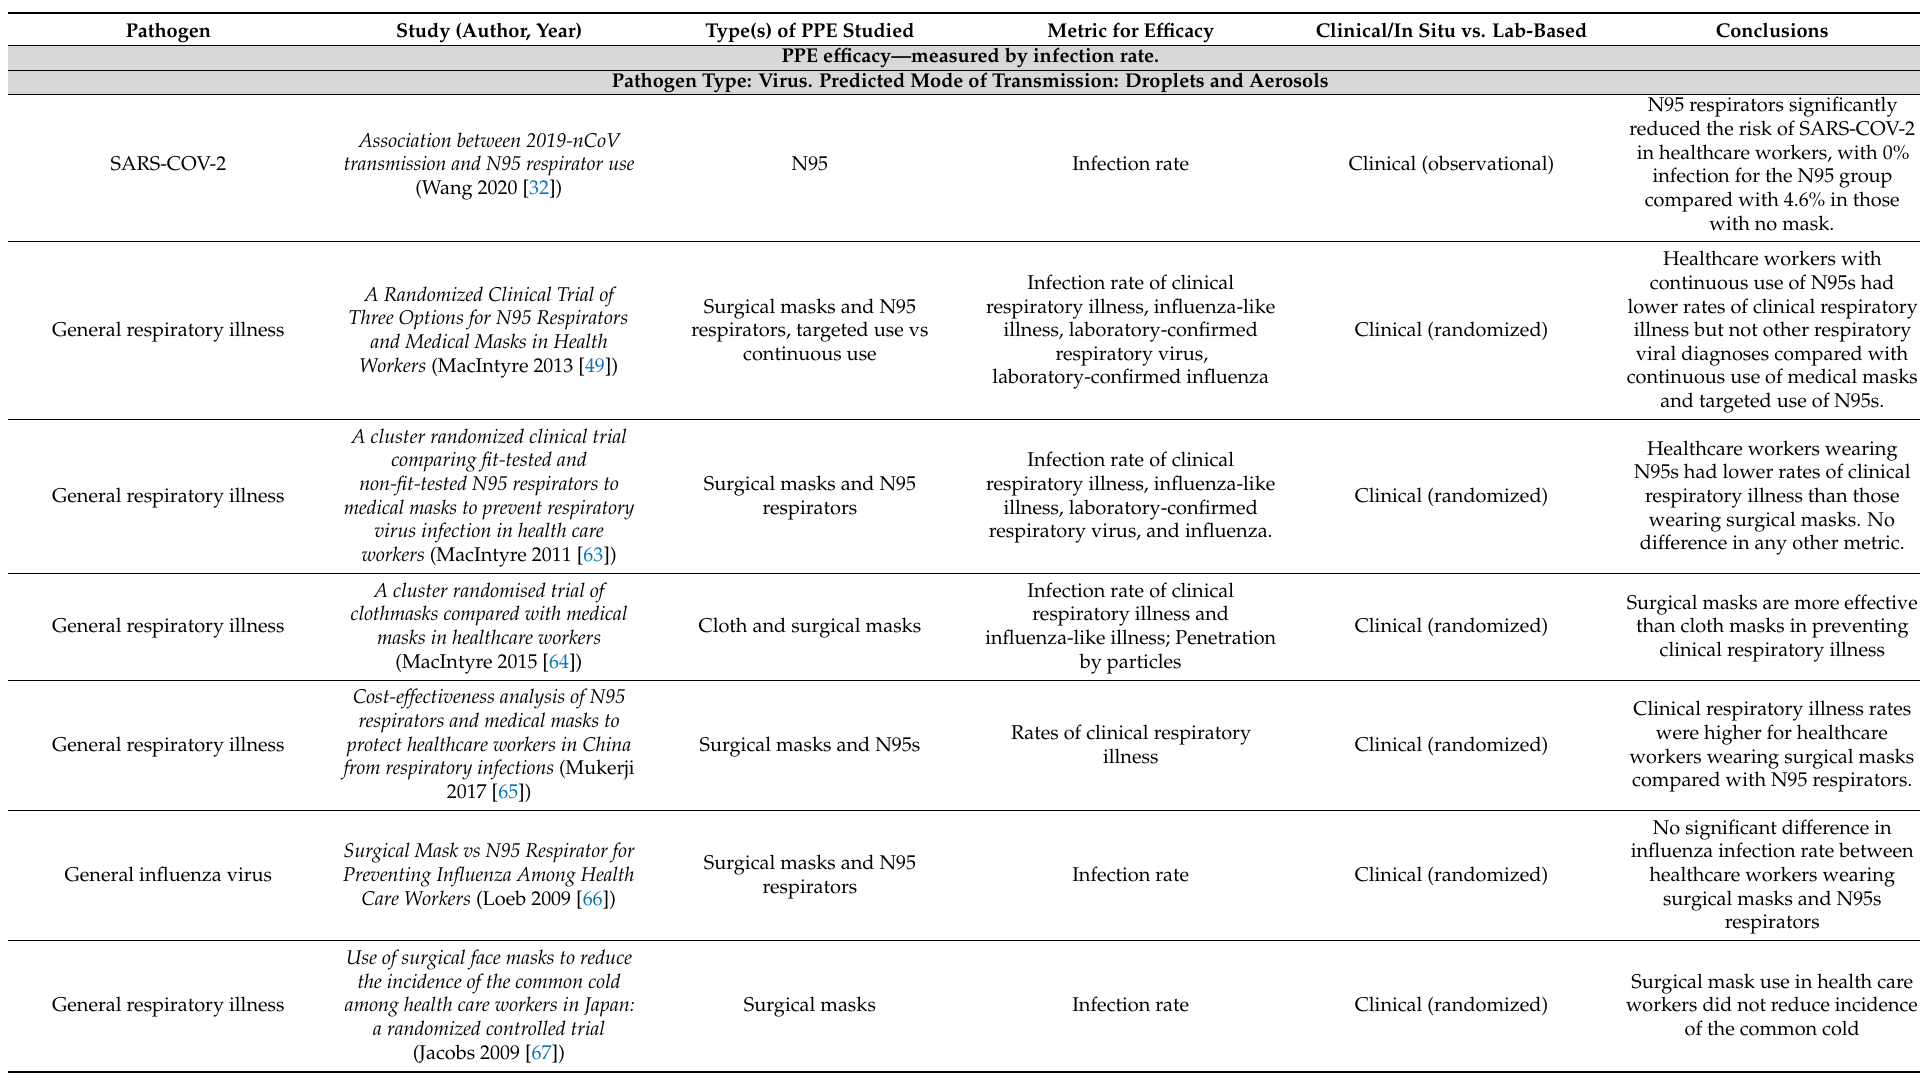
Table 3. Efficacy evaluations of